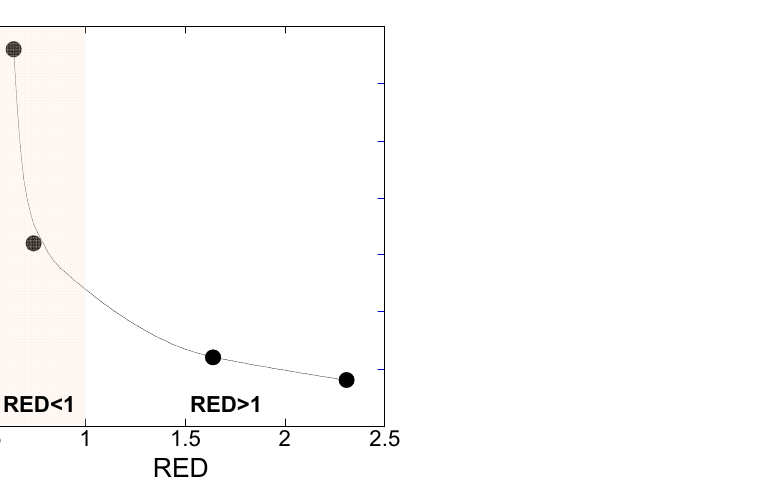
Figure 6. Crystallite sizes of sintered Ag films as a function of the RED values of solvents used for the ink.